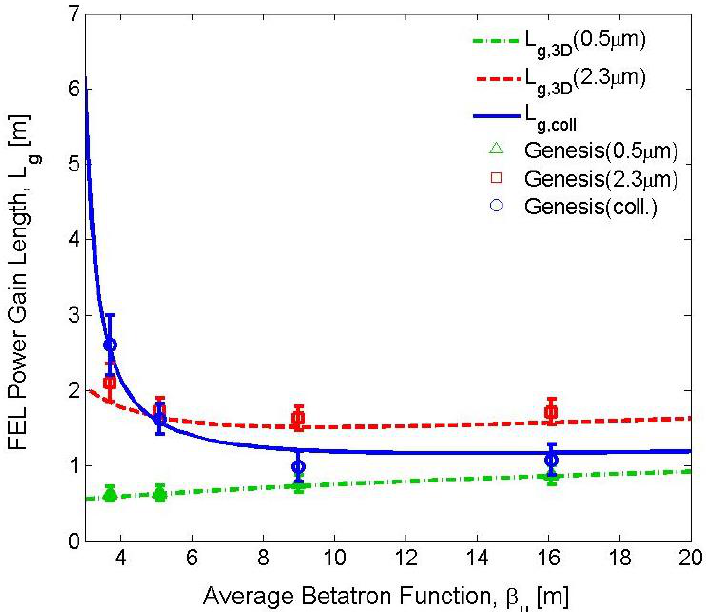
Figure 8. Gain length as function of the average betatron function in the undulator: analytical (lines) and from Genesis simulation results (symbols) (data from Table 1 in [44]). Error bars show the maximum variation of the gain length fit over several simulation runs. For each run used to fit L g,coll (blue circles), several random distributions of the bunch’s macro-slices in the transverse phase space were generated. In this case, each distribution (in each transverse plane) corresponds to a normalized projected emittance of 2.3  m, while the slice emittance is 0.5  m for all slices. The projected beam size is forced to fit the average betatron function selected for that run. For the two other cases shown in the Figure, the projected and the slice normalized emittances are equal, with value 0.5  m (green triangles) and 2.3  m (red squares), respectively. The average betatron function used for the abscissa is the geometric mean of the horizontal and the vertical  averaged along the undulator.